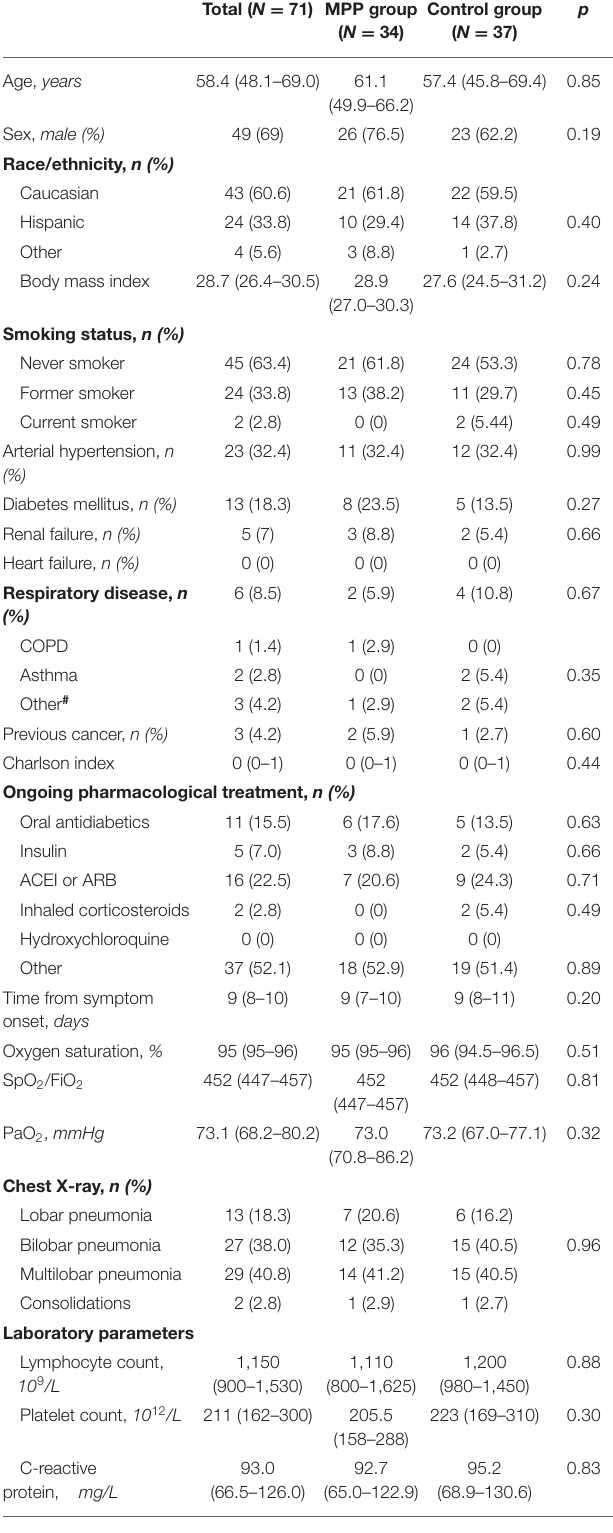
TABLE 1 | Baseline patient